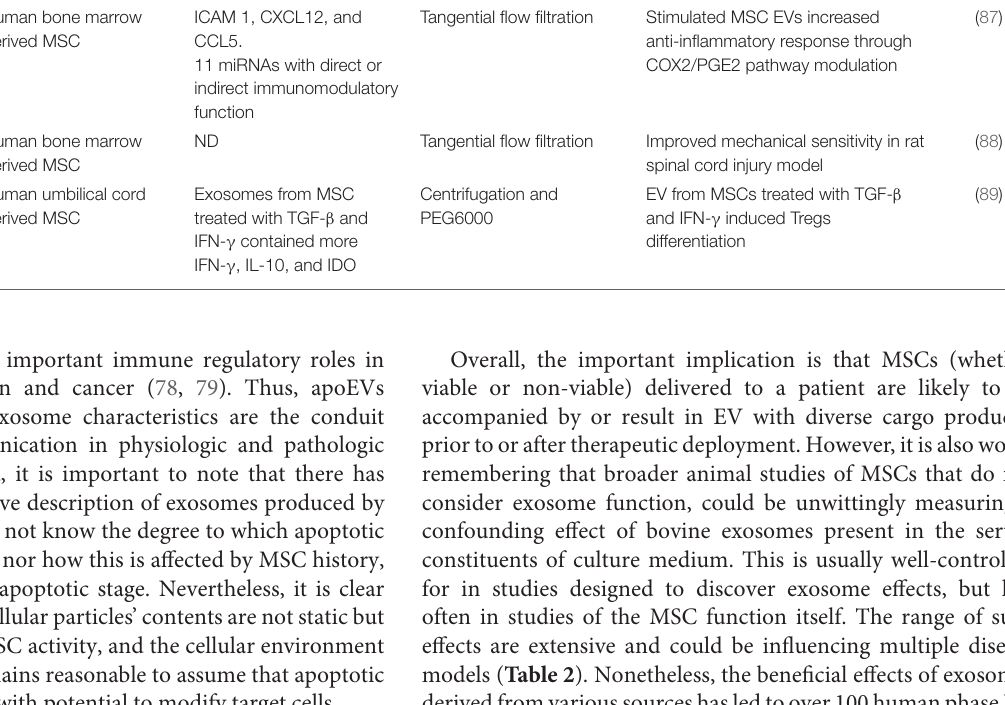
TABLE 3 | Studies showing the influence of inflammatory environment on human MSC-derived exosome cargo.